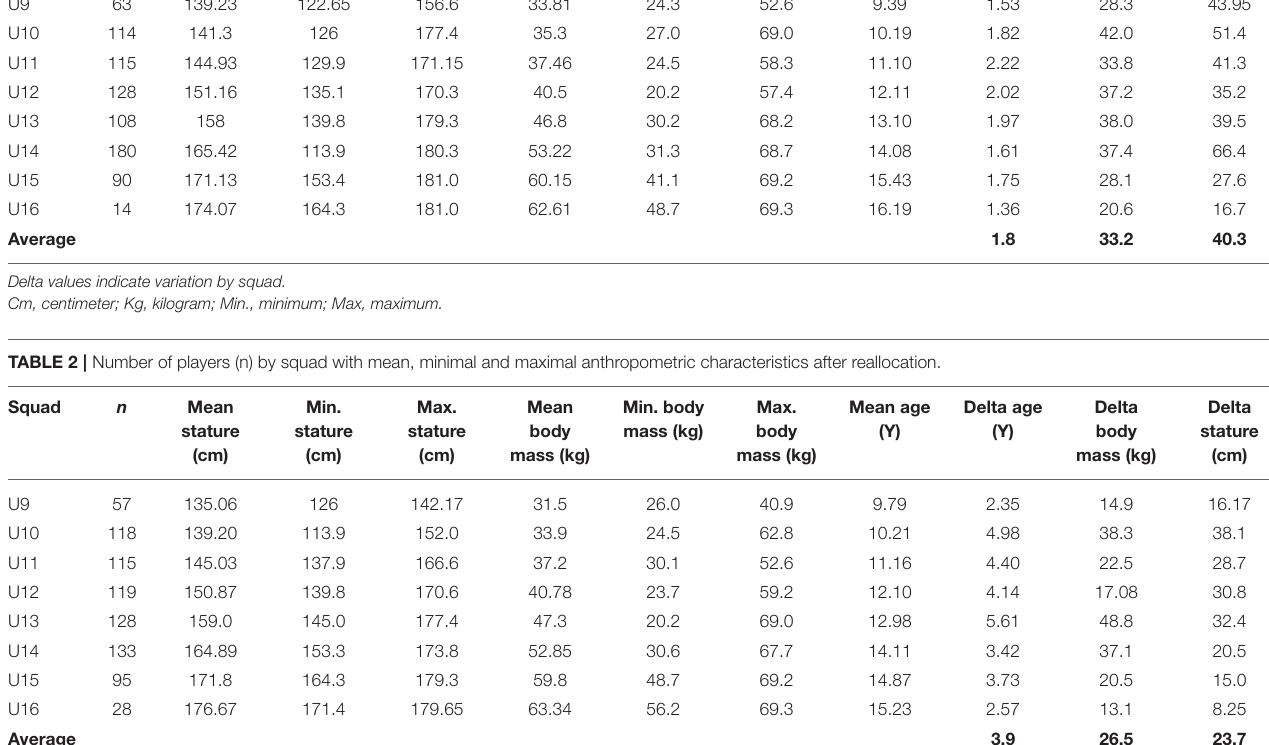
TABLE 1 | Number of players ( n ) by squad with mean, minimal and maximal anthropometric characteristics before reallocation. Squad n